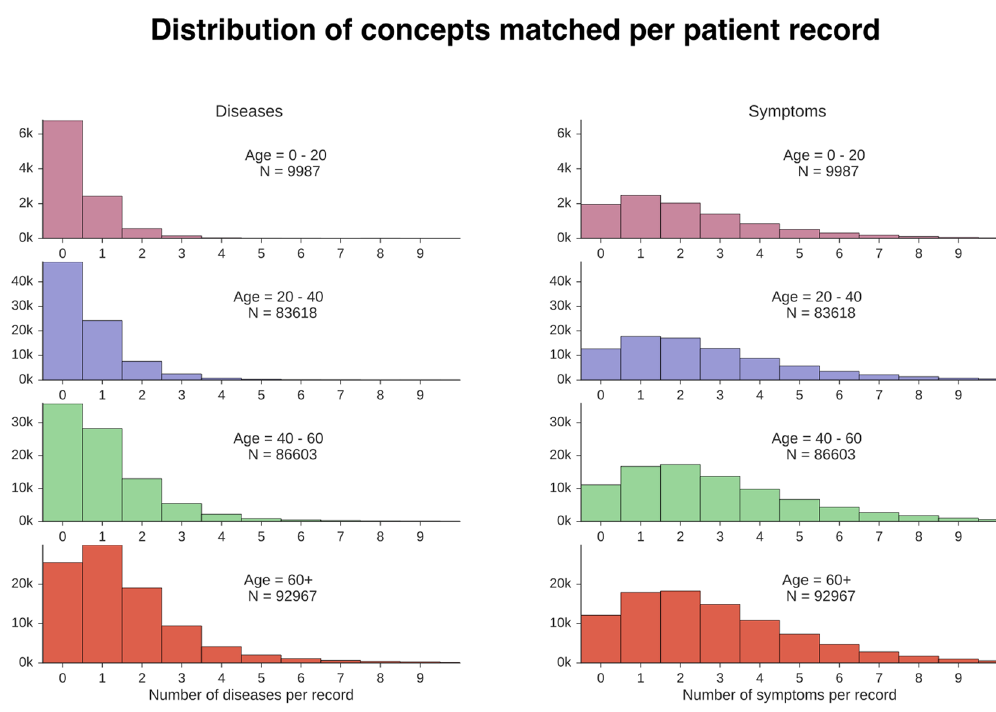
Figure 3. Distribution of number of diseases and symptoms per patient